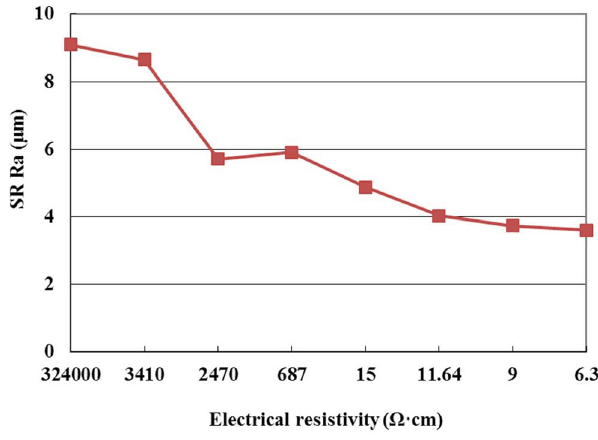
Figure 2. Effect of the electrical resistivity on MRR.